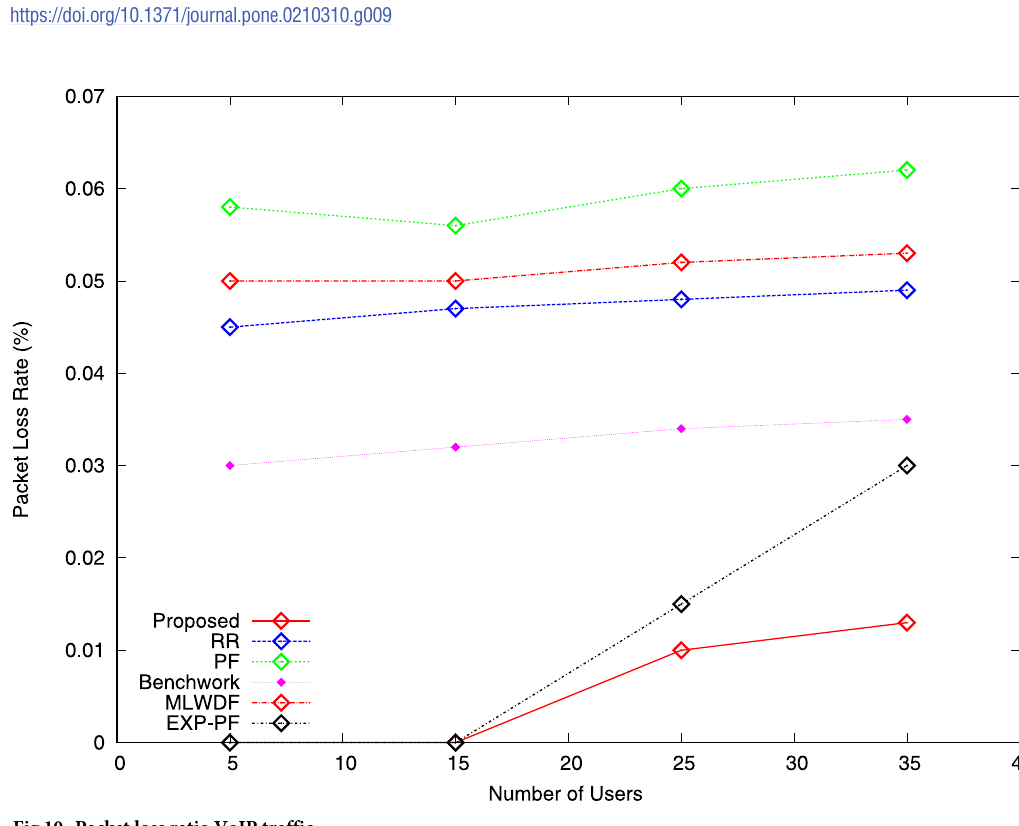
Fig 10. Packet loss ratio VoIP